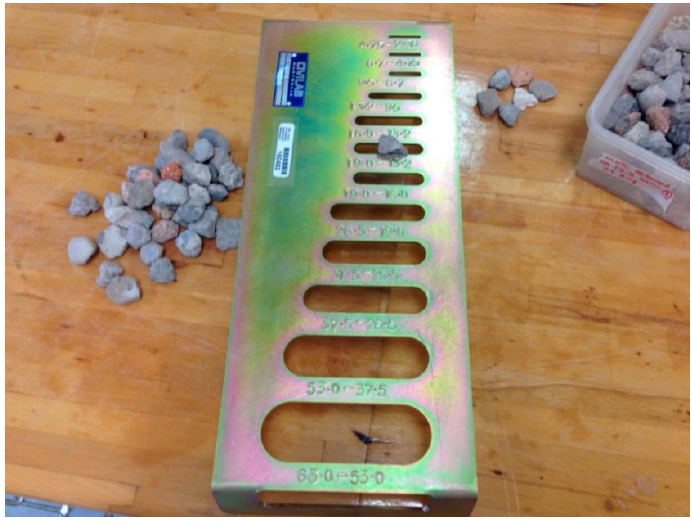
Figure 5. Conducting Flakiness Index Test for Coarse Aggregate.